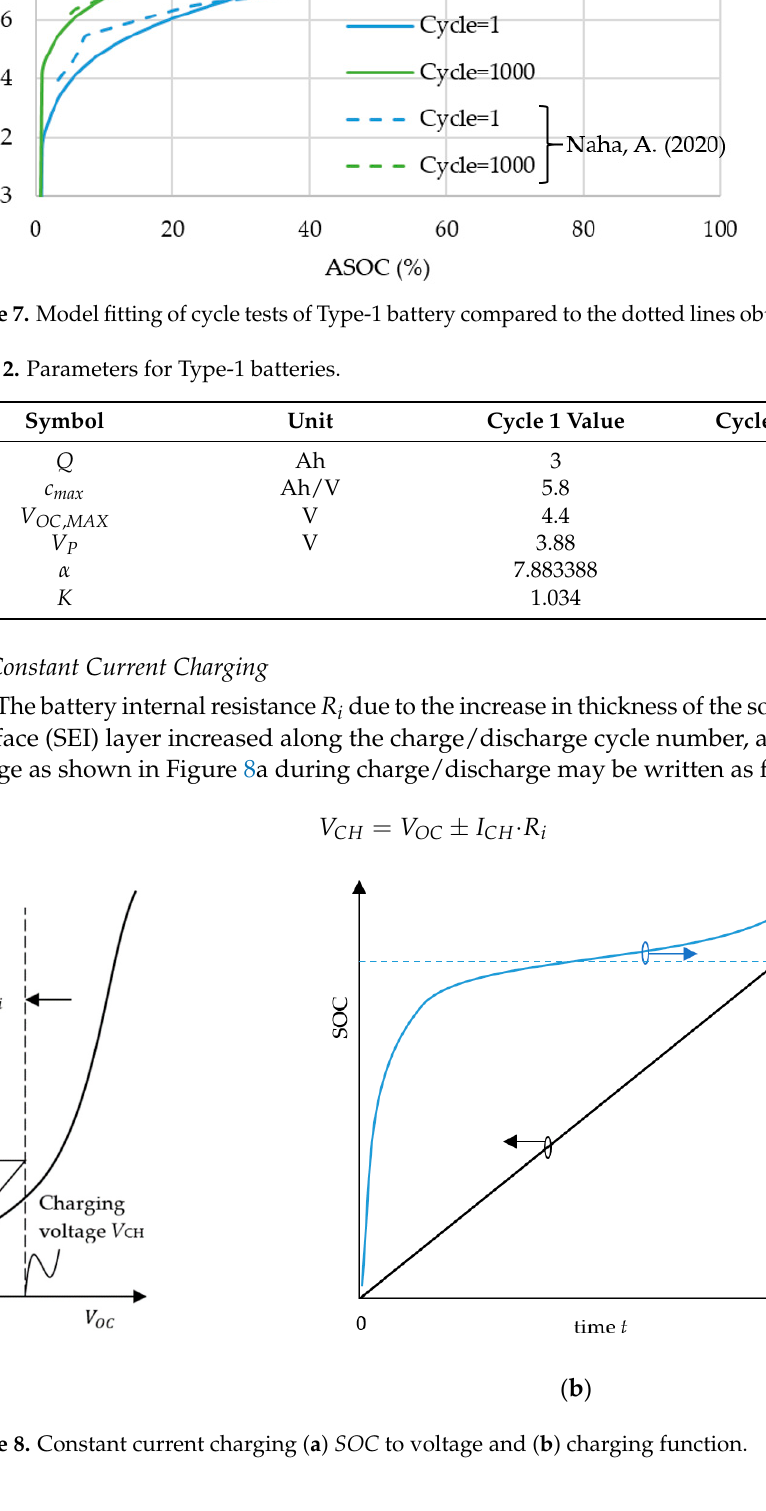
Figure 9. The reciprocal of charging voltage slew rate in constant current charging. 3.4. Charging Parallel Connected Batteries According to the derived result from the previous sections, the parallel connected batteries with two different peak capacitance voltages present different voltage slew rates about their individual V P ’s. The batteries’ voltage, after ageing both the maximum open circuit voltage and the peak capacitance, can become higher than the new one as